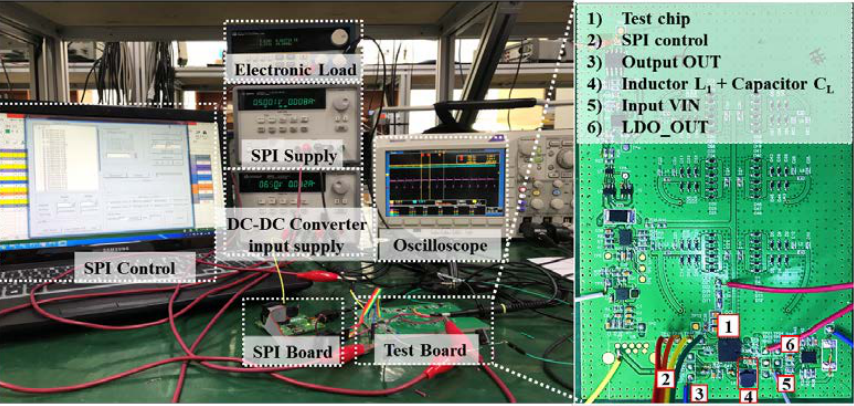
Figure 10. The measurement environment setup.